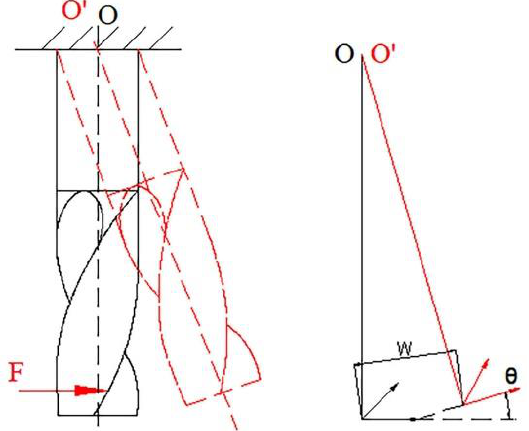
Figure 1. Bending and torsional deflection of a tool.